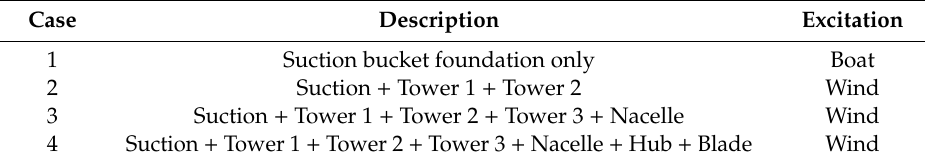
Table 6. Natural frequency test at each installation stage.